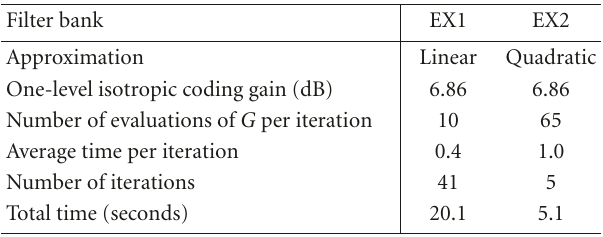
Table 1: Comparison of algorithms with linear and quadratic ap-